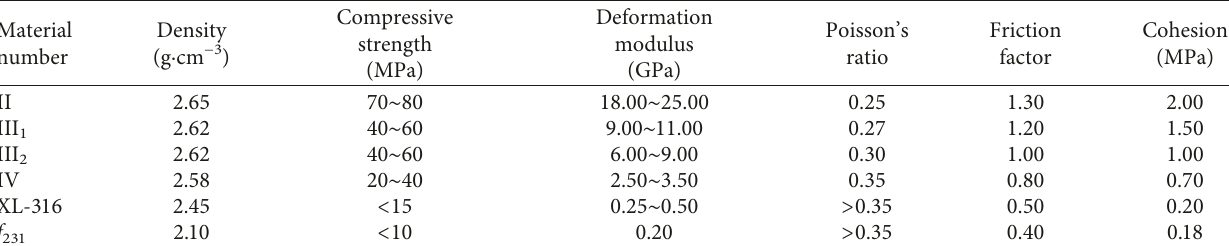
Table 2: Mechanical properties of the rock